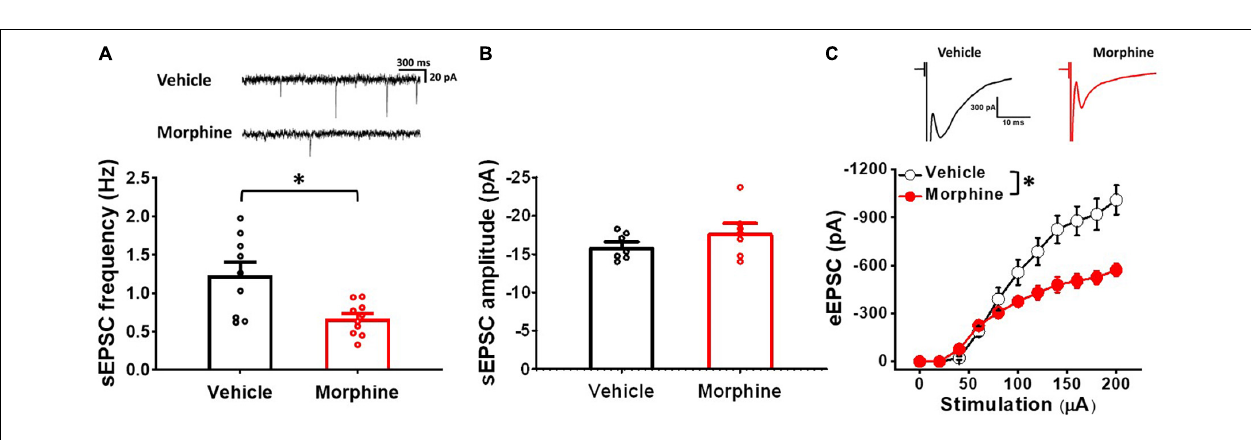
FIGURE 5 | Repeated morphine treatment decreased excitatory synaptic strength in sGABAn. (A) (top) Representative traces of sEPSC and (bottom) sEPSC frequency (effect size:–1.46, p = 0.012; Vehicle: N = 9, n = 143; Morphine: N = 10, n = 123). ∗ p < 0.05 by Welch’s t test. (B) sEPSC amplitude (effect